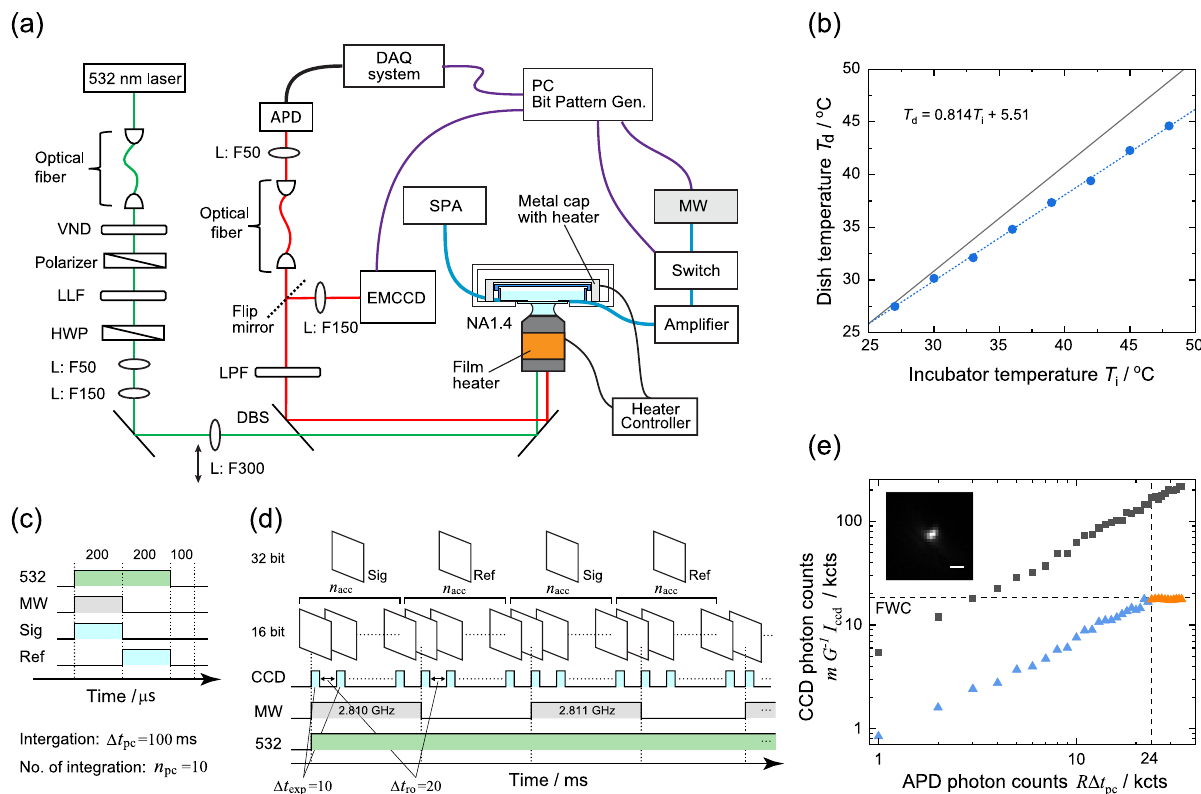
Figure 1. ( a ) Schematic of the ODMR setup including the optical microscope and microwave spin resonance systems. VND: variable neutral density filter LLF: laser-line filter. HWP: half-wave plate. L: lens. DBS: dichroic beam splitter LPF: long-pass filter. EMCCD: electron multiplying charge-coupled device camera APD: avalanche photodiode SPA: Spectrum analyzer. MW: microwave source. DAQ: data-acquisition board. ( b ) Calibration of the dish temperature ( T d ) with the incubator heat source ( T i ). T S = 5.51 + 0.814 T i (°C) is obtained. The dotted line represents the linear fit. The solid line indicates a slope of one. Pulse control sequences for ( c ) confocal detection and ( d ) wide-field ODMR detection. Sig: signal. Ref: reference. (cid:31) t ro : readout time, 20 ms. n acc : number of image accumulations, 50 or 100. (cid:31) t exp : exposure time of the camera, 10 ms. The frequency sweep in the wide- field ODMR started at 2.810 GHz with a step frequency of 1 MHz. ( e ) The relation between the detected photon counts, under the exposure time of (cid:31) t exp = 10 ms , obtained using the camera ( mG − 1 I ccd ) and the APD photon count for an integration time of (cid:31) t pc = 10 ms ( R (cid:31) t pc ). Blue and orange triangles indicate single maximal pixel values, whereas gray squares indicate the sum over 6 × 6 pixels. At R (cid:31) t pc = 24 kcts, mG − 1 I ccd reaches the FWC, thereby exhibiting saturation. (Inset) wide-field fluorescence image of the target ND. Scale bar: 1 µ m